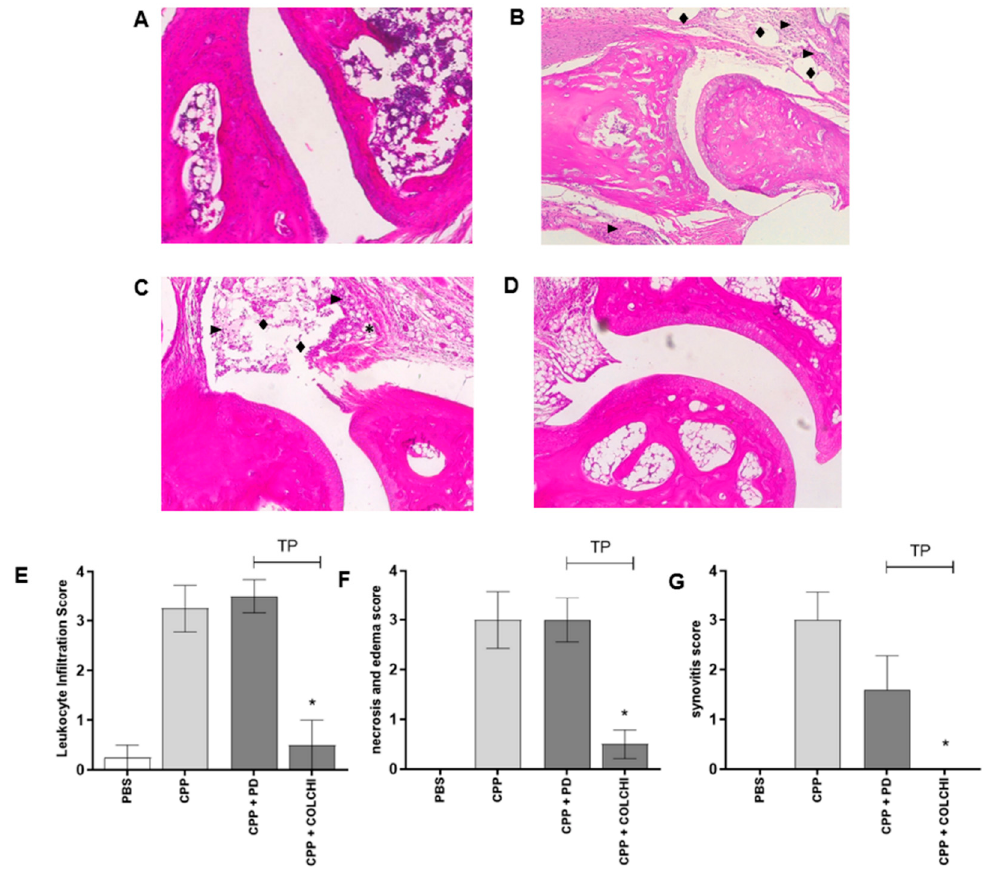
Figure 6. Leukocyte infiltration, necrosis and edema, and synovitis scores calculated on H&E-stained sections of the ankles 48 h after CPP crystal injection. Mice were treated by gavage with PD (40 mg/kg) or colchicine (1 mg/kg) after (therapeutic) the injection of the crystals (0.3 mg/20 µ L) (n = 8/group). Histological sections: ( A ) PBS 20 μ L; ( B ) CPP; ( C ) CPP + PD (therapeutic); ( D ) CPP + colchicine (therapeutic). Symbols depict inflammatory infiltrate ( ► ), edema ( ♦ ) and necrosis ( * ). Magnification 10x. Histological parameters: ( E ) leukocyte infiltration, Kruskal–Wallis test p = 0.0019, * p < 0.05 vs. CPP; ( F ) necrosis and edema, Kruskal–Wallis test p = 0.0016, * p < 0.05 vs. CPP; ( G ) synovitis, Kruskal–Wallis test p = 0.0086, * p < 0.05 vs.